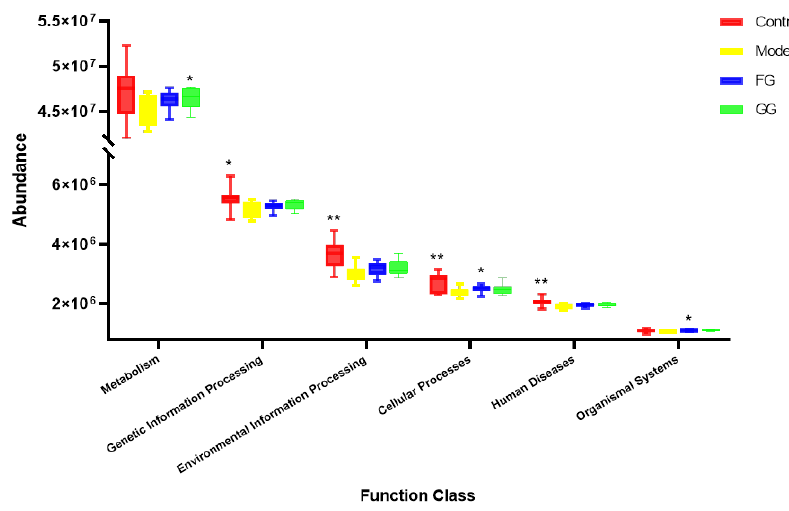
Figure 17. KEGG pathway level 1 box diagram ( n = 10; * p < 0.05; ** p < 0.01 compared with the model group).